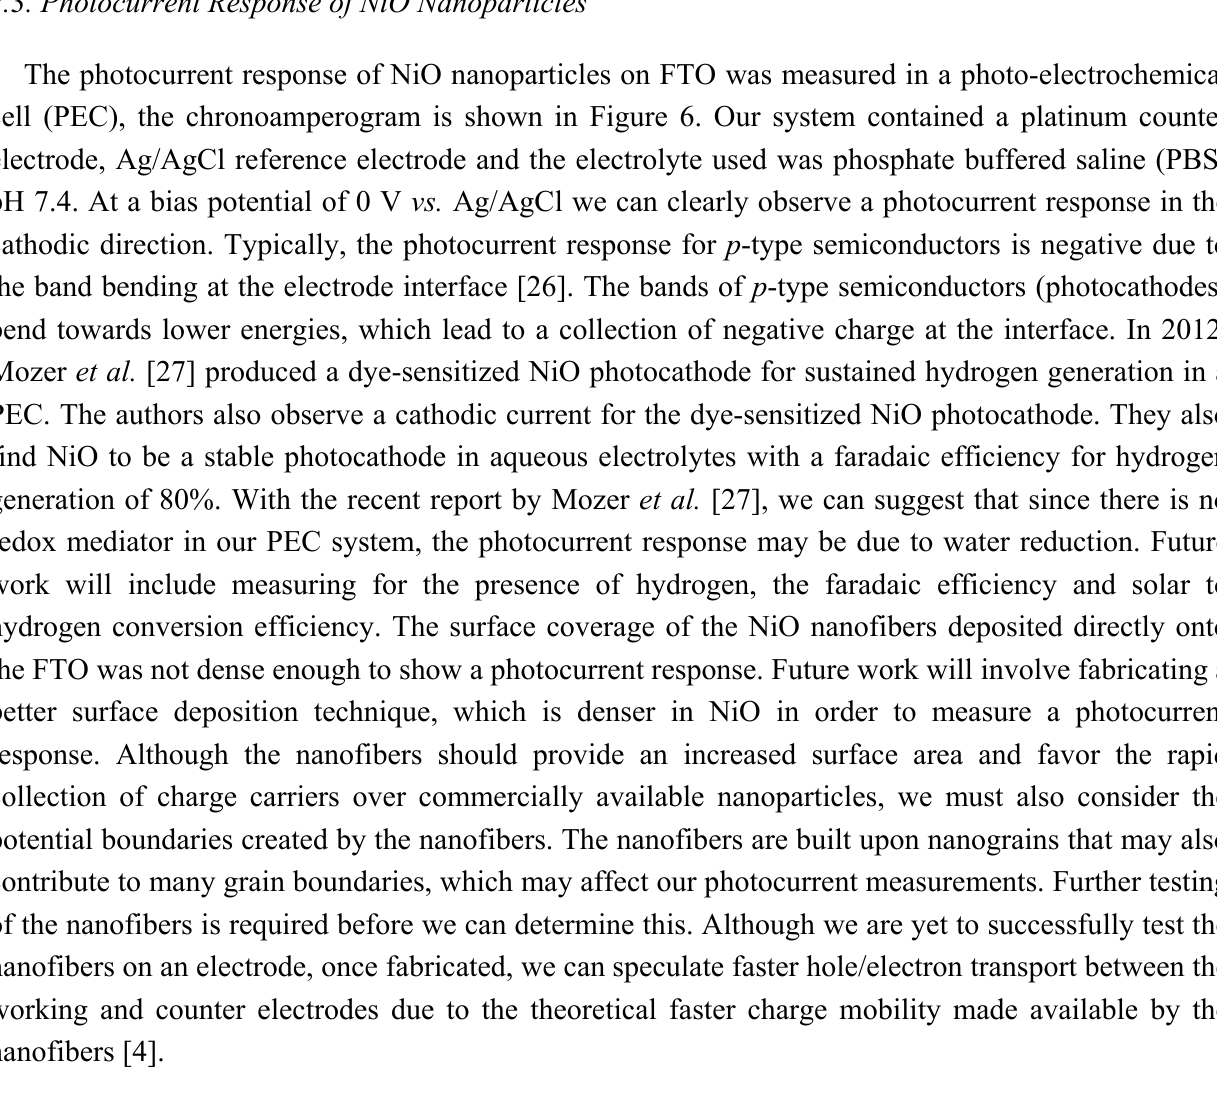
Figure 6. Chronoamperogram for the photocurrent as a function of time for NiO nanoparticles on